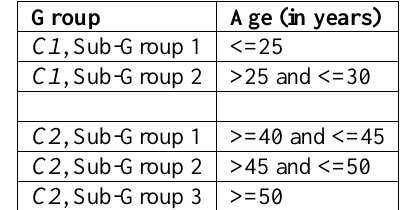
Fig. 8 Average response time for dDSST version